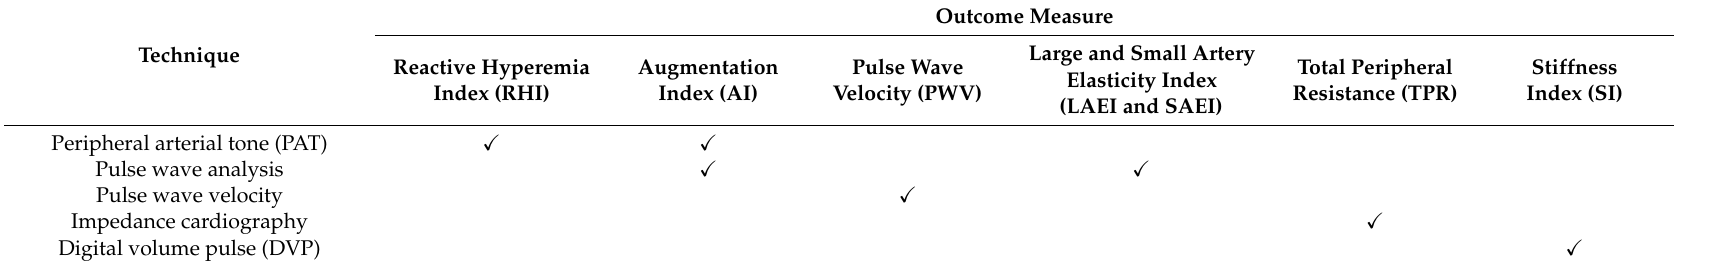
Table 1. Techniques used to assess vascular function and outcome